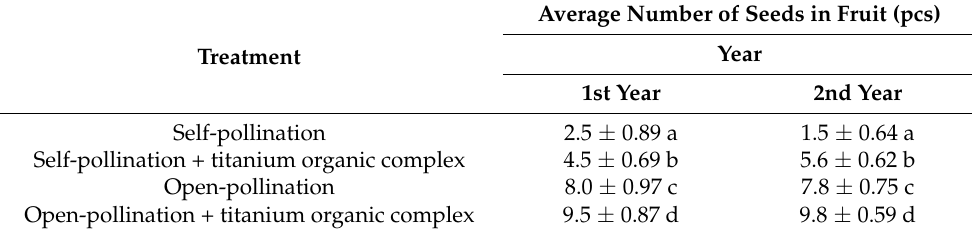
Table 2. The effect of titanium organic complex application on the average number of seeds in apple fruit (pieces).